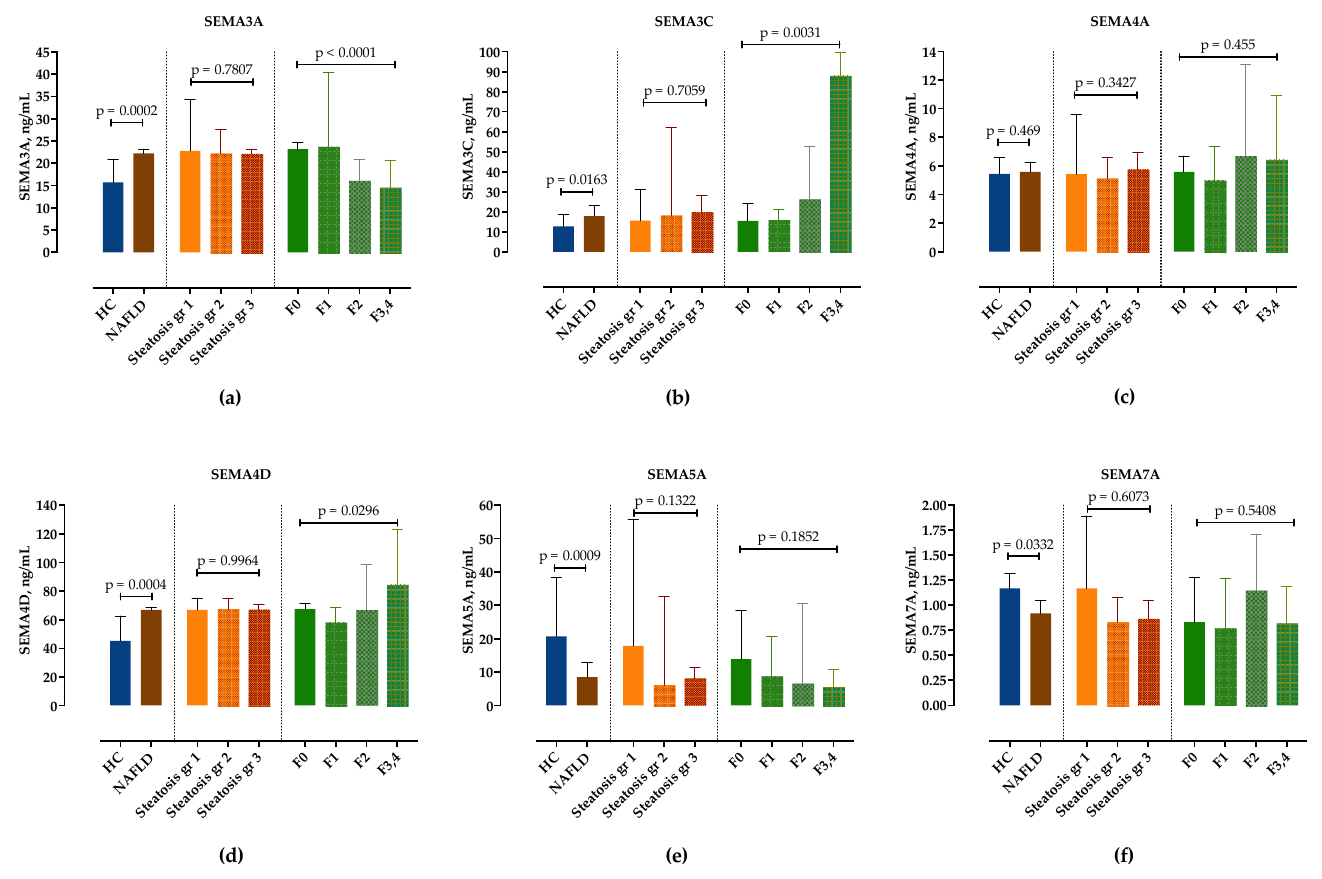
Figure 1. Serum concentrations of semaphorin SEMA3A ( a ), SEMA3C ( b ), SEMA4A ( c ), SEMA4D ( d ), SEMA5A ( e ) and SEMA7A ( f ) measured by ELISA in healthy controls and in patients with NAFLD, stratified by steatosis grade and fibrosis stage. Data are presented as median with interquartile range. The p -values are calculated by Mann – Whitney U-test or Kruskal – Wallis test, as appropriate.